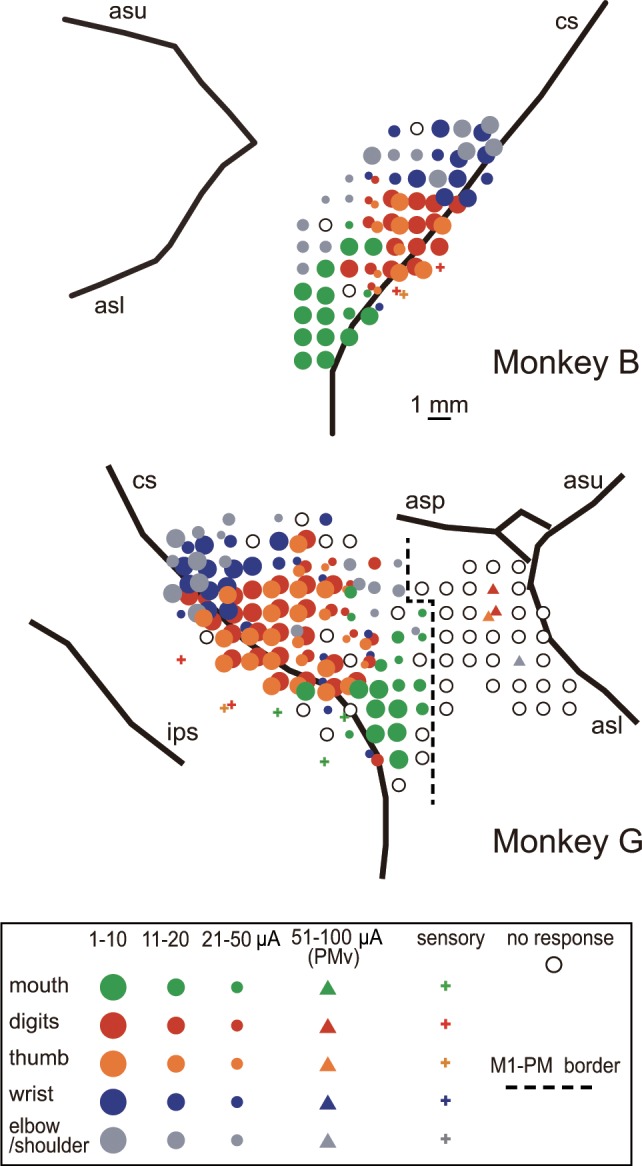
The intracortical microstimulation (ICMS) maps of the monkeys.Movement elicited at the indicated thresholds and the sensory response to light tactile stimuli are indicated by the symbols. Some electrode penetration sites showed no response to either ICMS at currents up to 50 μA for M1 (or up to 100 μA for PMv) or sensory stimulation (open circles). The dashed line indicates the presumed border between M1 and the premotor cortex, which was determined by the movement thresholds and sulcal landmarks. asl, lower limb of the arcuate sulcus; asp, arcuate spur; asu, upper limb of the arcuate sulcus; cs, central sulcus; ips, intraparietal sulcus.